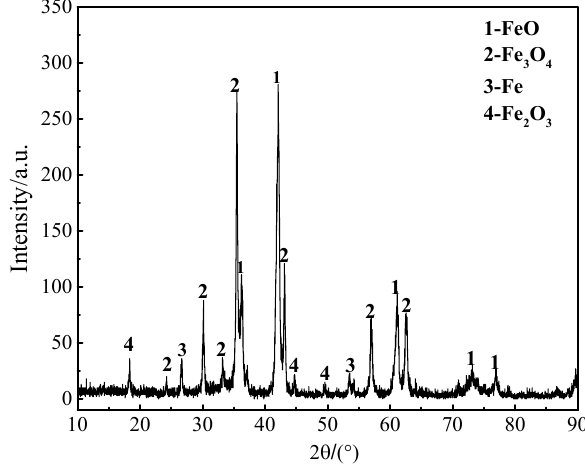
Figure 2. X-ray pattern of iron oxide scale.